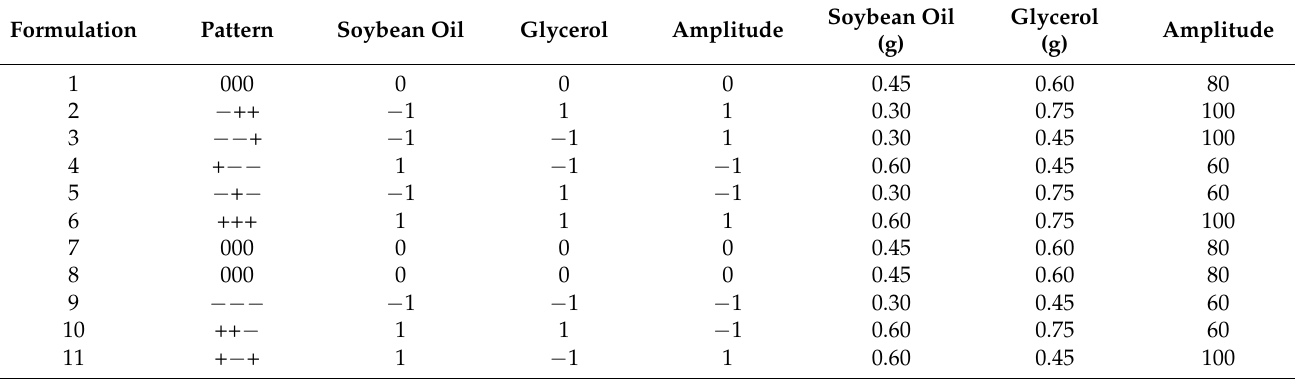
Table 2. Experimental factorial design using CTAB as model surfactant.